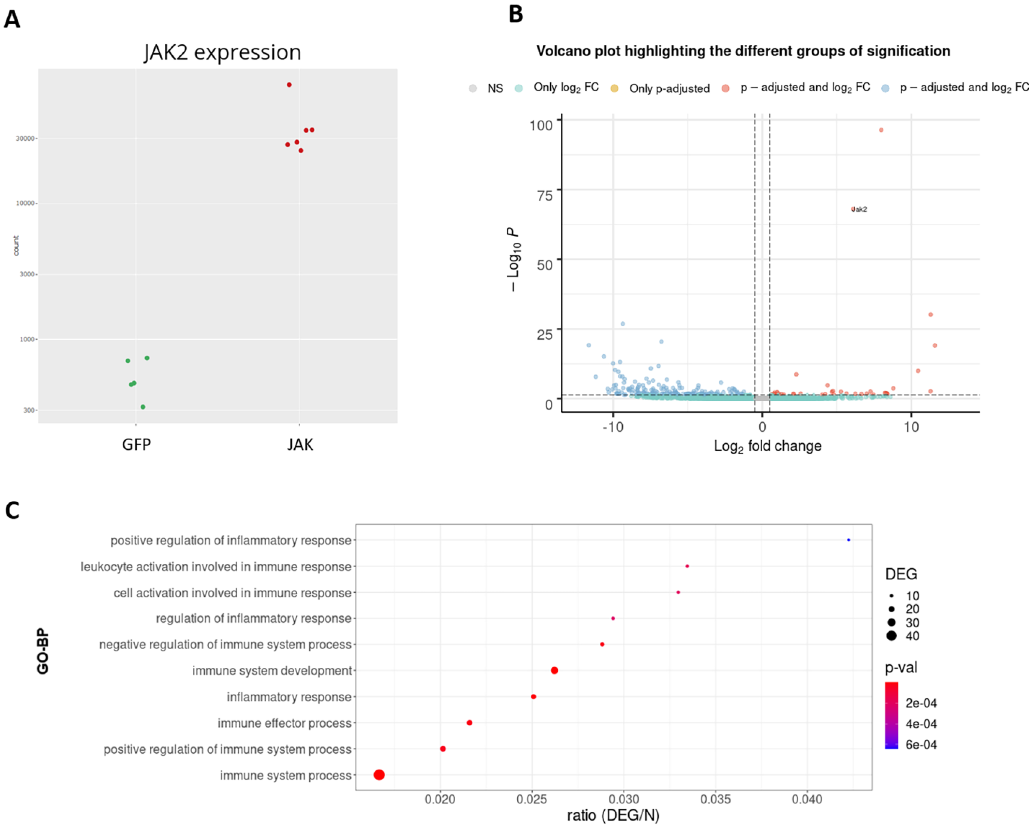
Figure 11. RNA-seq analysis of the JAK2-STAT3 pathway in astrocytes of a Huntington ’ s disease model mouse. A: Expression levels of the Jak2 gene between groups. B: Volcano plot. C: GO-BP enriched